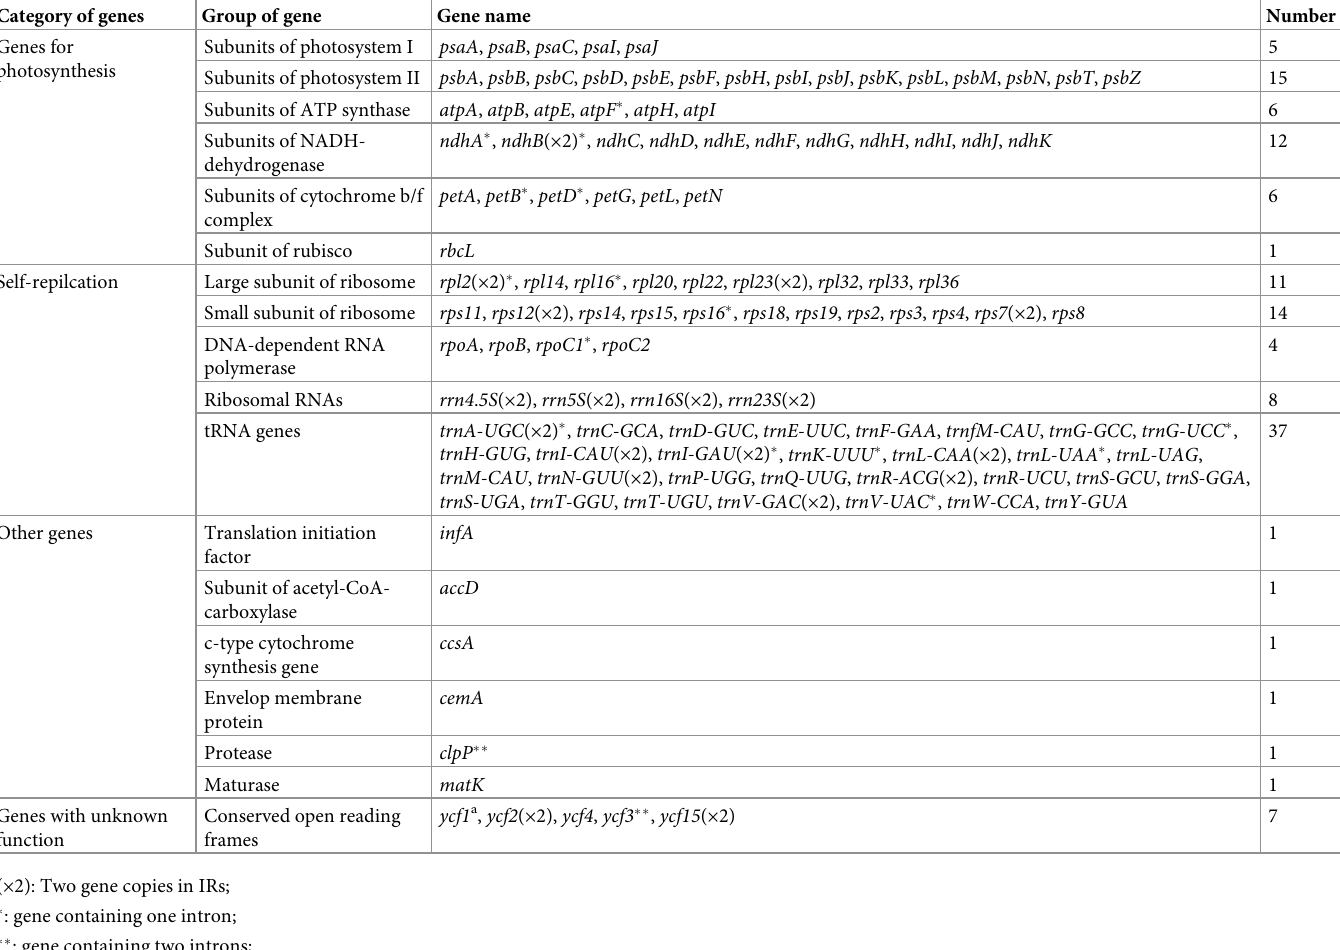
Table 2. Genetic composition of the cp genomes of three Carpesium